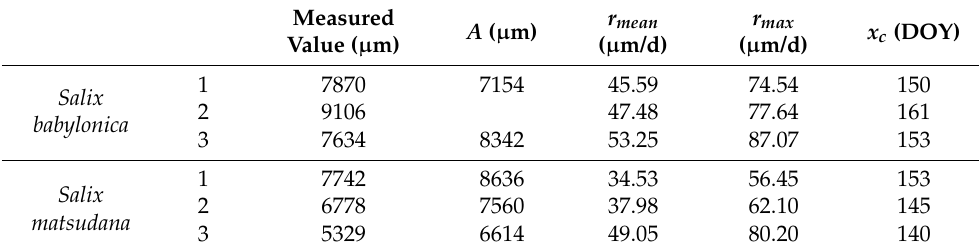
Table 2. Measured and fitted values of radial growth increment in 2018.